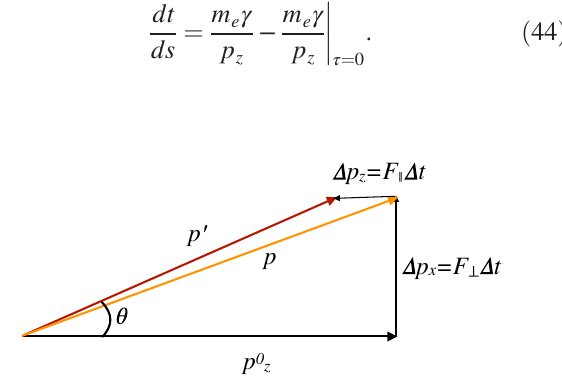
FIG. 7. The diagram for momentum change through a harmonic kicker. The initial momentum is p 0